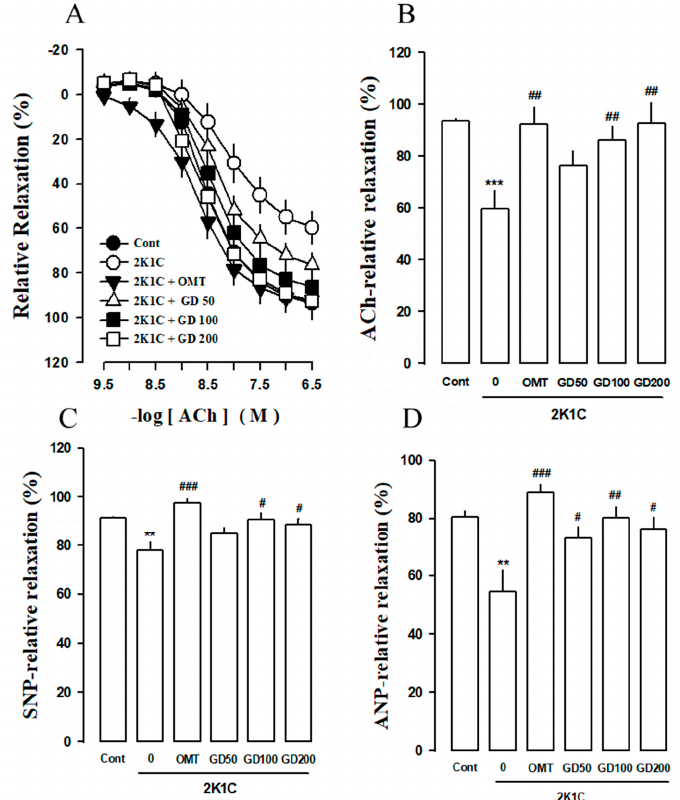
Figure 3. Vasorelaxation e ff ect of Gynura divaricata (L.) DC (GD) following acetylcholine (ACh), sodium nitroprusside (SNP), and atrial natriuretic peptide (ANP) treatments. ( A ) Dose-response curves of ACh relaxation in the thoracic aorta of the 2K1C model; ( B ) The final ACh dose was changed in % change expression with each group; ( C ) Dose-response curves of SNP relaxation in the thoracic aorta of the 2K1C model; ( D ) E ff ect of GD on the ANP relaxation of the 2K1C model. Responses are expressed as the percentage of relaxations relative to the PE-induced pre-contractions. Each value shows the mean ± standard error ( n = 10 per group). ** p < 0.01, *** p < 0.001, vs. CONT and # p < 0.05, ## p < 0.01, ### p < 0.0001 vs.